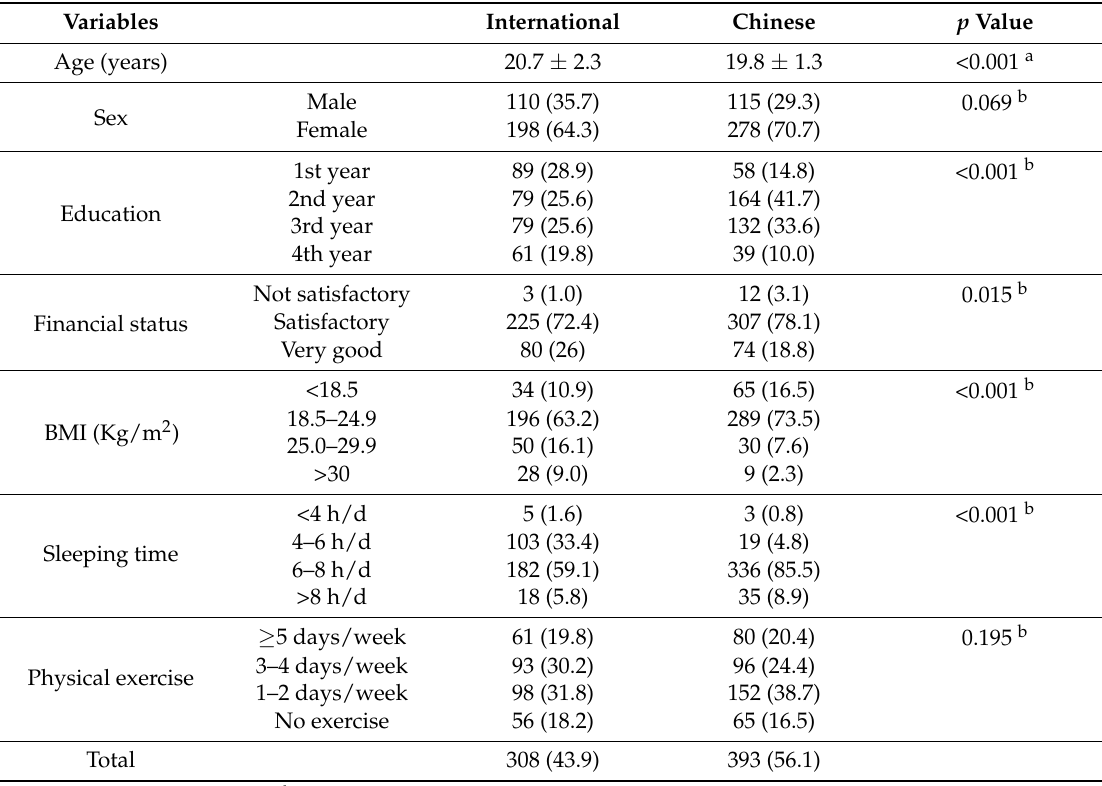
Table 1. Baseline characteristics of international and Chinese